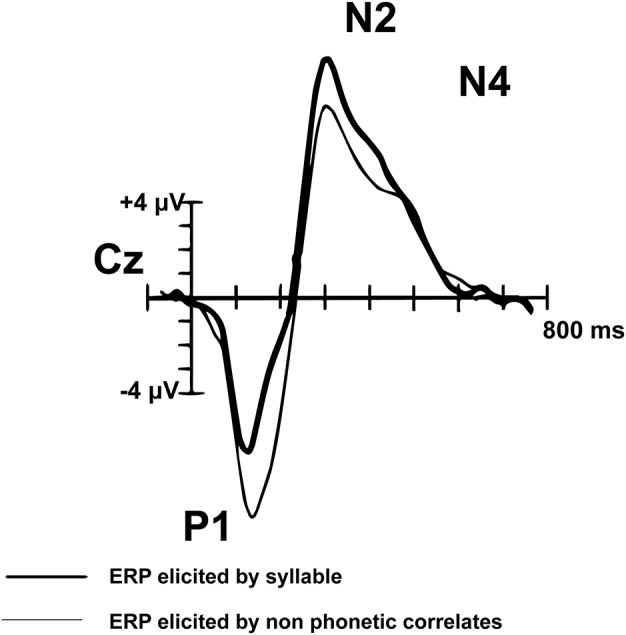
Pediatric (n = 14) syllable (bold) and non-speech ERP grand-average waveform from Cz (adapted from Ceponiene et al., 2005). The P1, N2, and N4 peaks are evident in the pediatric auditory waveform. In contrast to the matured adult AEP waveform, the N1 and P2 peaks are not observed in children.